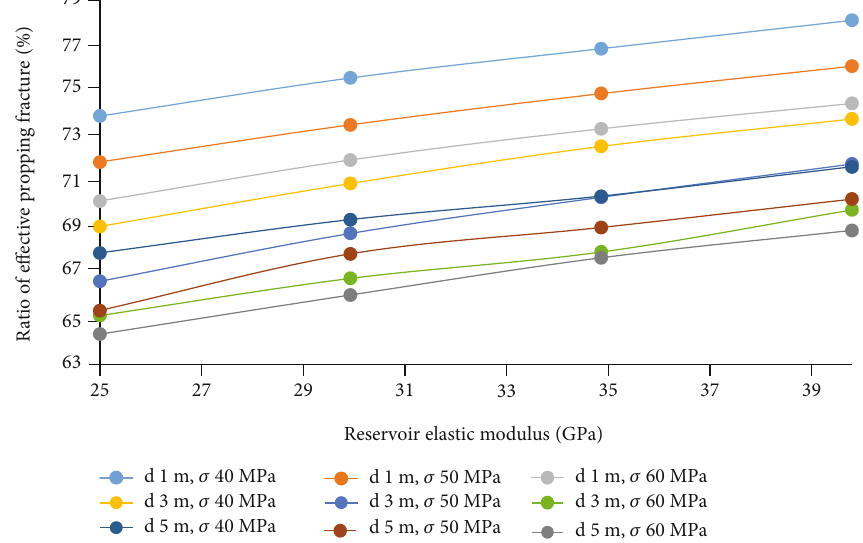
Figure 40: The in fl uence of reservoir elastic modulus at 5 mm height and di ff erent diameters on the ratio of e ff ective supporting